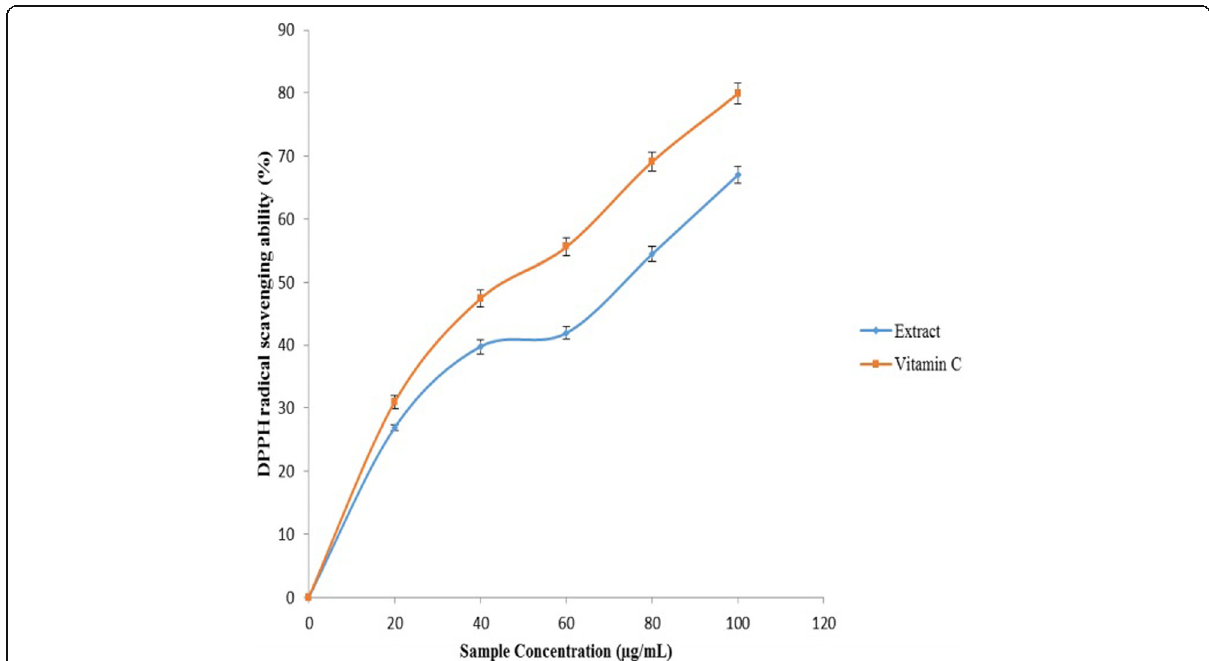
Fig. 5 DPPH radical scavenging ability of aqueous extract of O. gratissimum leaves and vitamin C